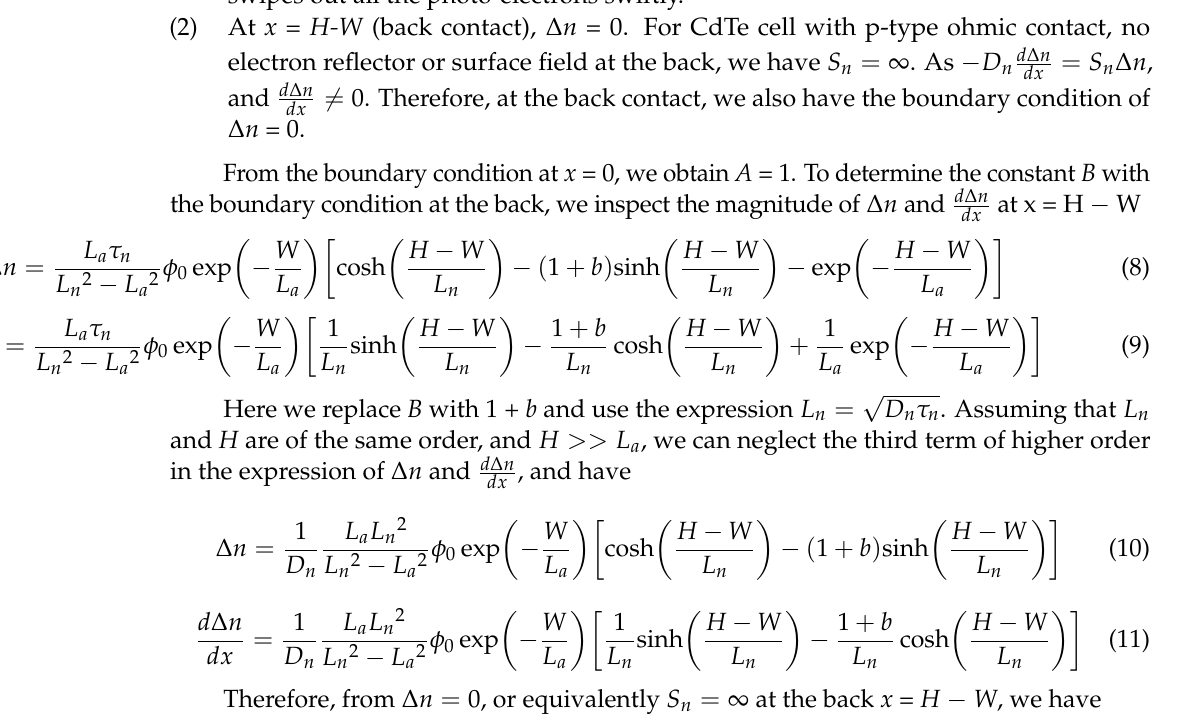
Figure 4. The relationship between ∆ n and x of the general solution . x is defined as any position in the neutral region. The unit of ∆ n is cm − 3 .